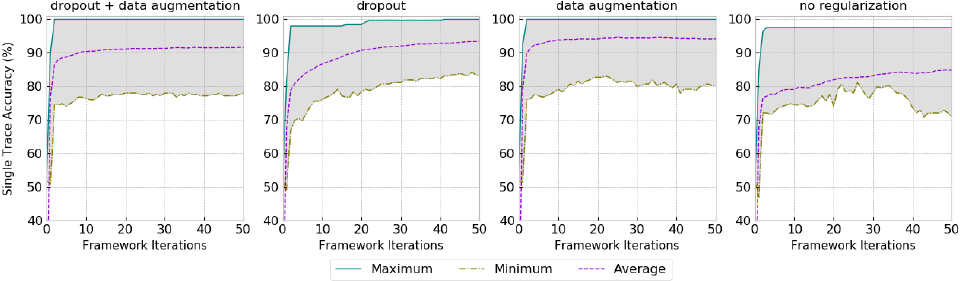
Figure 8: Minimum, maximum, and average single trace accuracy with iterative framework on the cswap-pointer